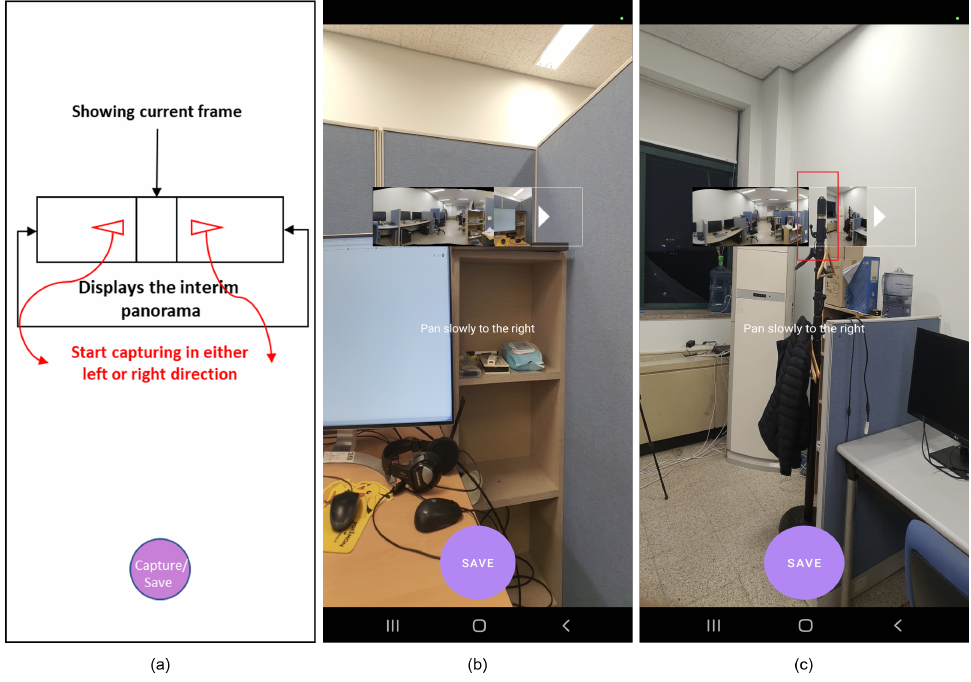
Figure 6. ( a ) GUI’s sketch of the panorama application; ( b ) GUI of the panorama application with the Sense-Panorama method, indicating successful stitching is in progress; ( c ) GUI of the panorama application without the Sense-Panorama method, the highlighted red box indicates discontinuation due to stitching